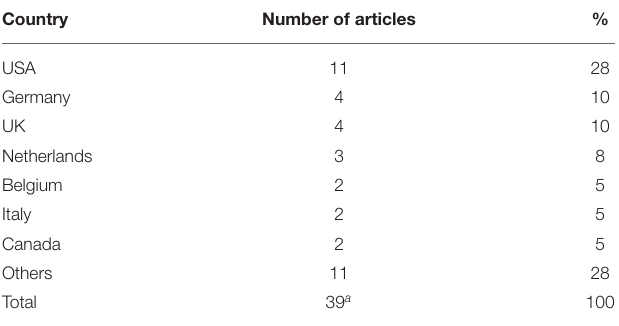
TABLE 4 | Location of empirical research.